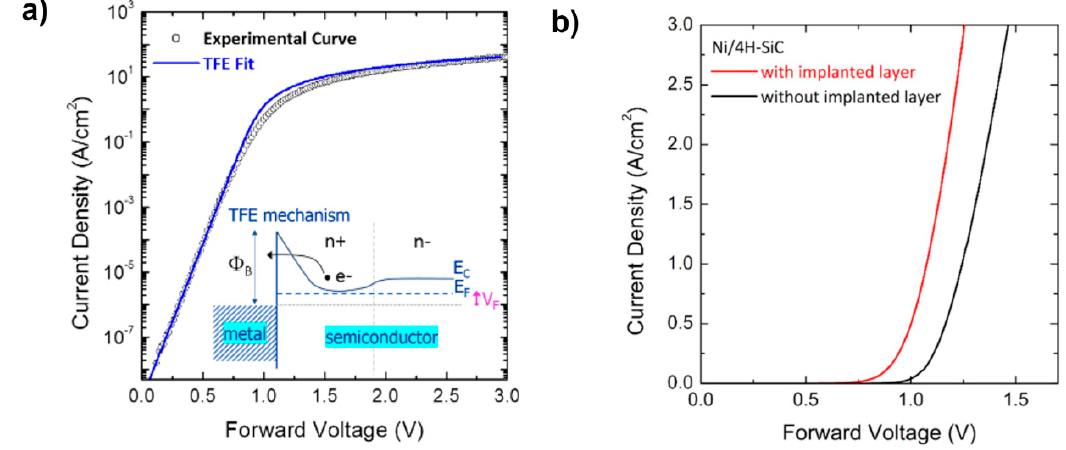
Figure 15. ( a ) Forward current density–voltage characteristics (open symbols) for Ni/n-type implanted-4H-SiC Schottky diode and fitting curve according to the TFE model (continuous line). In the inset, schematic energy band diagram for the metal/4H-SiC contact under forward bias, according to the TFE current transport mechanism. ( b ) Forward current density–voltage characteristics of the Ni Schottky contacts to n-type 4H-SiCwith or without a heavily doped n-type implanted layer. (Figure extracted from Ref. [100]).